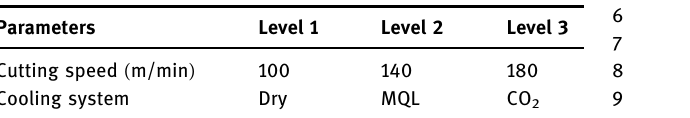
Table 2: Test parameters Parameters